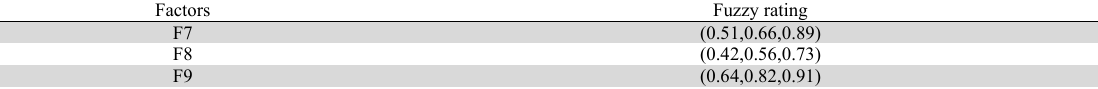
Average rating for each user readiness factor